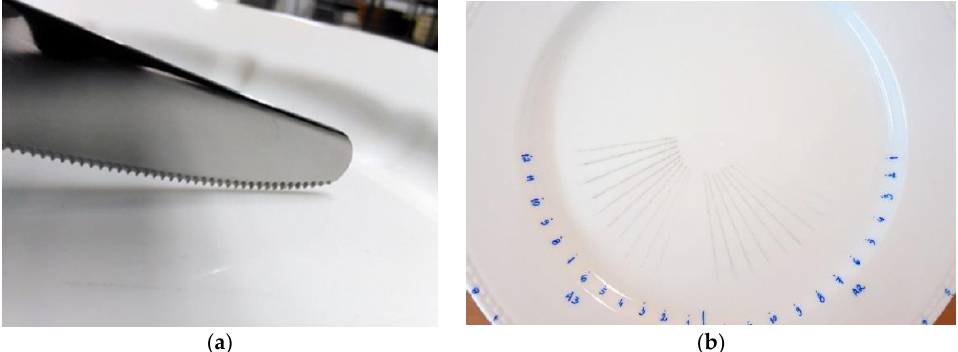
Figure 6. Metal marking definition ( a ) a knife contacting with a glaze ( b ) porcelain plate after metal marking test, on which it is possible to observe the presence of gray marks.